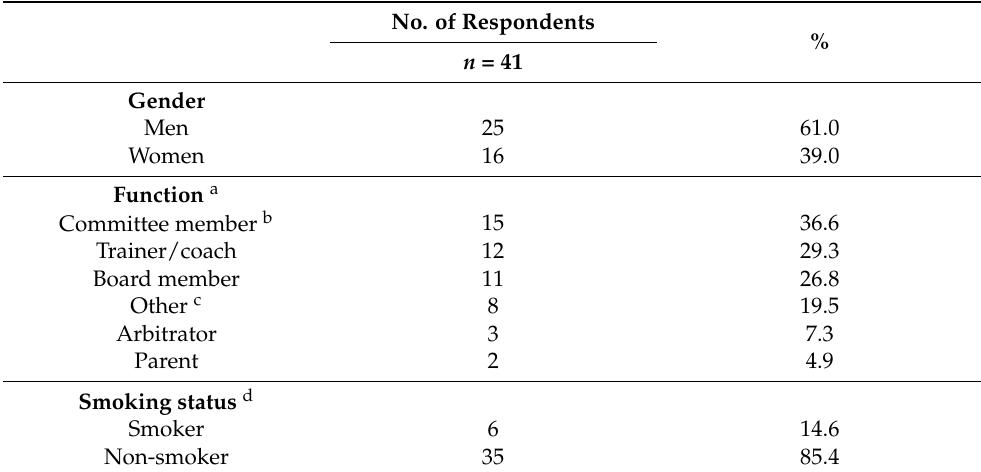
Table 2. Characteristics of the